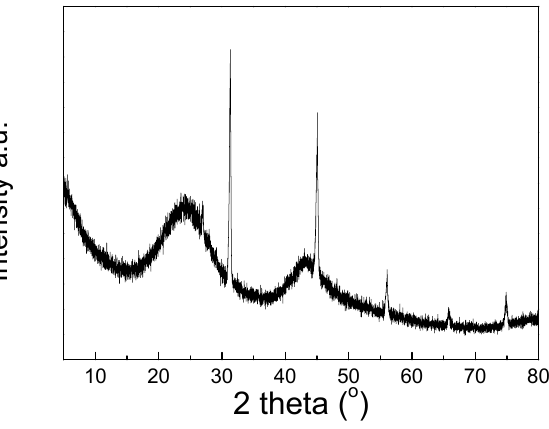
Figure 6. The XRD pattern of the biochar.